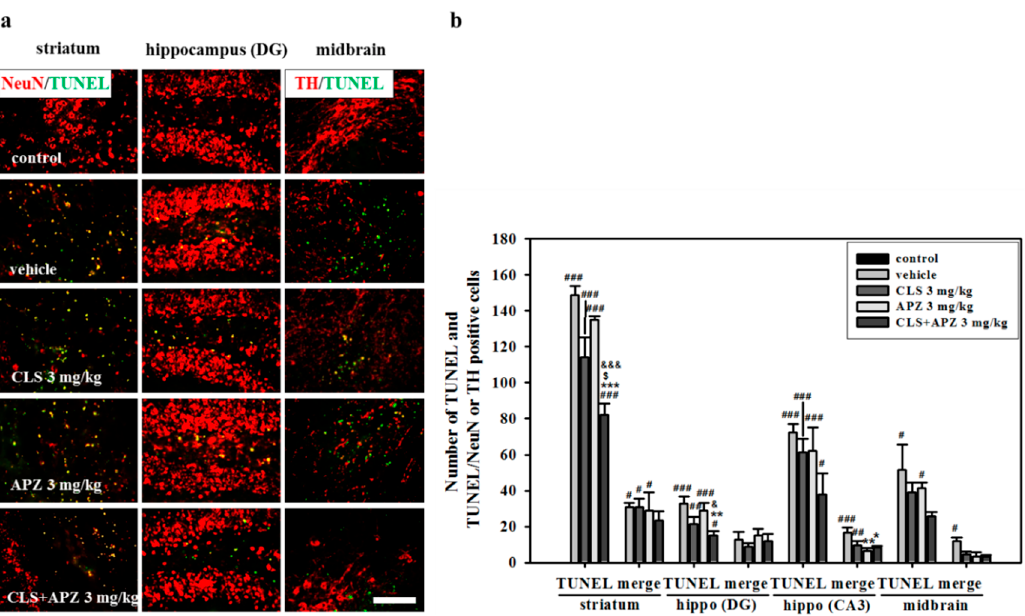
Figure 3. Effect of APZ augmentation on neuronal cell death in CLS-treated mice. Photomicrograph ( a ) and its histogram ( b ) for apoptosis marker TUNEL (terminal deoxynucleotidyl transferase dUTP nick end labeling) and TUNEL/neuronal cell marker NeuN or dopaminergic neuron marker TH in the striatum, hippocampus, and midbrain ( n = 5). TUNEL positive cells were significantly decreased by the combined use of APZ and CLS in the striatum and DG of the hippocampus. The combined use of APZ and CLS also reduced the number of TUNEL/NeuN-double positive cells in the CA3 of the hippocampus. DG, dentate gyrus; CA3, cornu ammonis; hippo, hippocampus. # p < 0.05, ## p < 0.01 and ### p < 0.001 versus control mice; * p < 0.05, ** p < 0.01 and *** p < 0.001 versus vehicle-treated mice; $ p < 0.05 versus CLS-treated mice; & p < 0.05 and &&& p < 0.001 versus APZ-treated mice. Scale bars = 100 μ m.